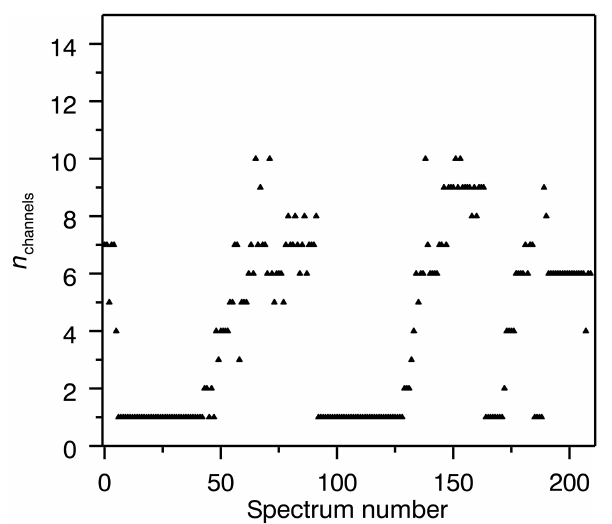
Figure A3. Adjustment (cid:49) IWV to the first-guess value IWV LHATPRO derived in the IWV fit for the spectra included in the FIR continuum data